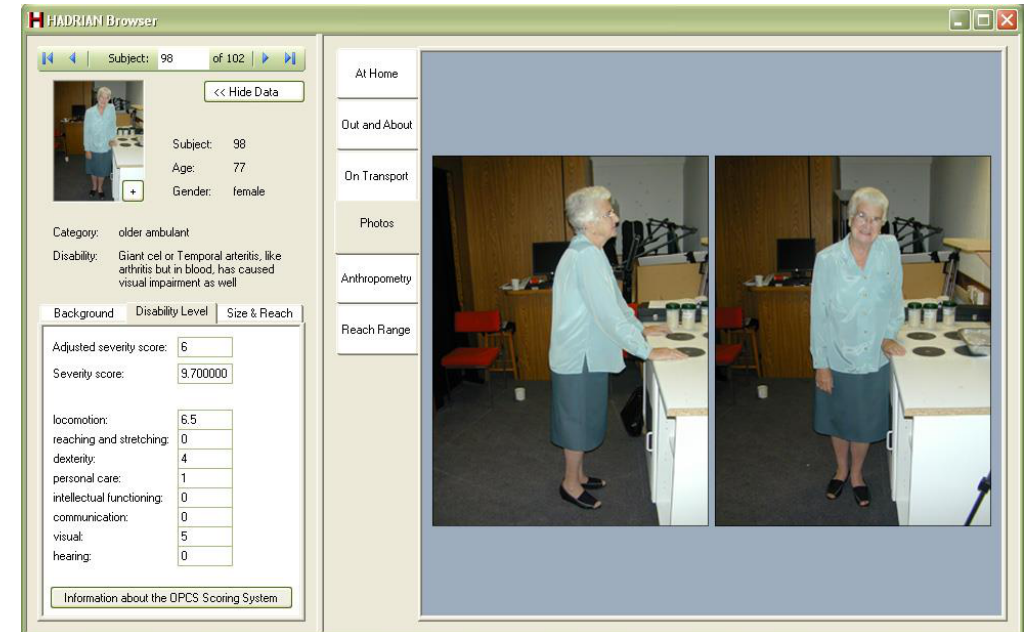
Figure 1. HADRIAN database interface showing overview information on the individual (left) and a range of detailed in- formation in this instance photos for empathy (right).